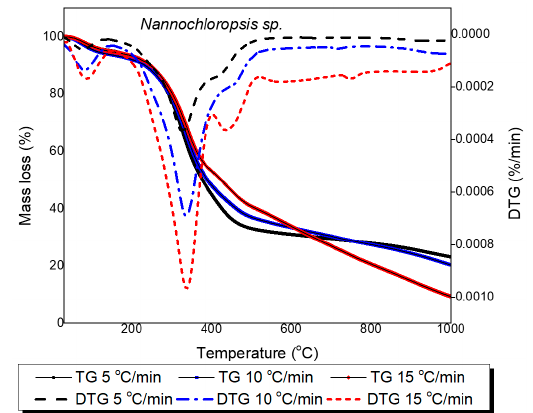
Figure 2. TG and DTG curves at 5, 10, and 15 ◦